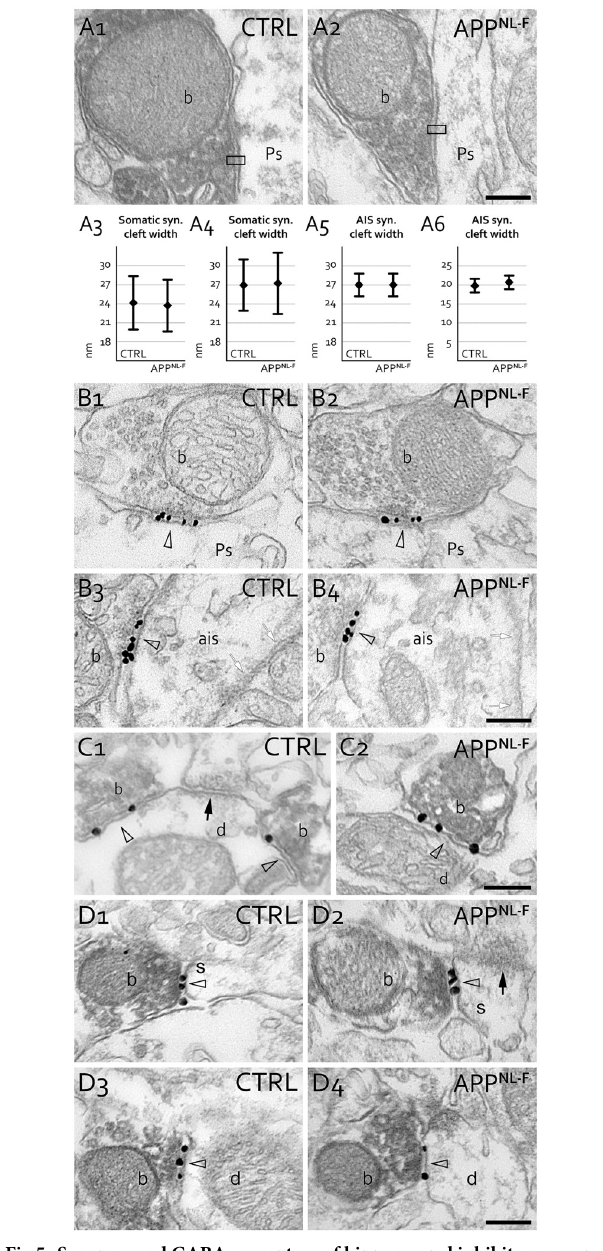
Fig 5. Synapses and GABA A receptors of hippocampal inhibitory synapses in APP NL-F mice. A: Synaptic cleft width (profiles tested in black frame) of PV-positive (DAB dark precipitate) somatic or AIS terminals (b: bouton) on CA1 pyramidal cell somata (A1-2, Ps: pyramidal cell some) or AIS in 18-month-old APP NL-F mice were not significantly different on somata (in two pairs of mice, A3-4) or on AISs (in two pairs of mice, A5-6) compared to WT mice (CTRL). Scale bar: 200 nm. B: Immunogold-labeled GABA A γ 2 receptor subunit localization in the synapses (arrowheads) established by somatic terminals (B1, B2) and terminals innervating axon initial segments (ais, B3, B4) in 17- and 21-month-old WT (CTRL) and APP NL-F mice, respectively. No changes were found in their GABA A γ 2 receptor content. Small white arrows indicate AIS specific membrane undercoating. Scale bar: 200 nm. C: Synaptic GABA A receptor labeling of SOM-positive terminals is similar in WT (CTRL, C1) and APP NL-F mice (C2). Electron micrographs show immunogold-labeled GABA A γ 2 receptor subunits in synapses (arrowheads) established by SOM positive terminal boutons (b, labeled with DAB) on postsynaptic dendrites (d) in CA1 stratum lacunosum-moleculare of 17-month-old mice. Black arrow shows an unlabeled synaptic contact of a SOM-negative bouton (C1). Scale bar: 200 nm. D: The GABA A receptor labeling of cholinergic synapses in the hippocampus is similar in WT (CTRL, D1, D3) and APP NL-F (D2, D4) littermate mice. Electron micrographs show immunogold-labeled GABA A γ 2 receptor